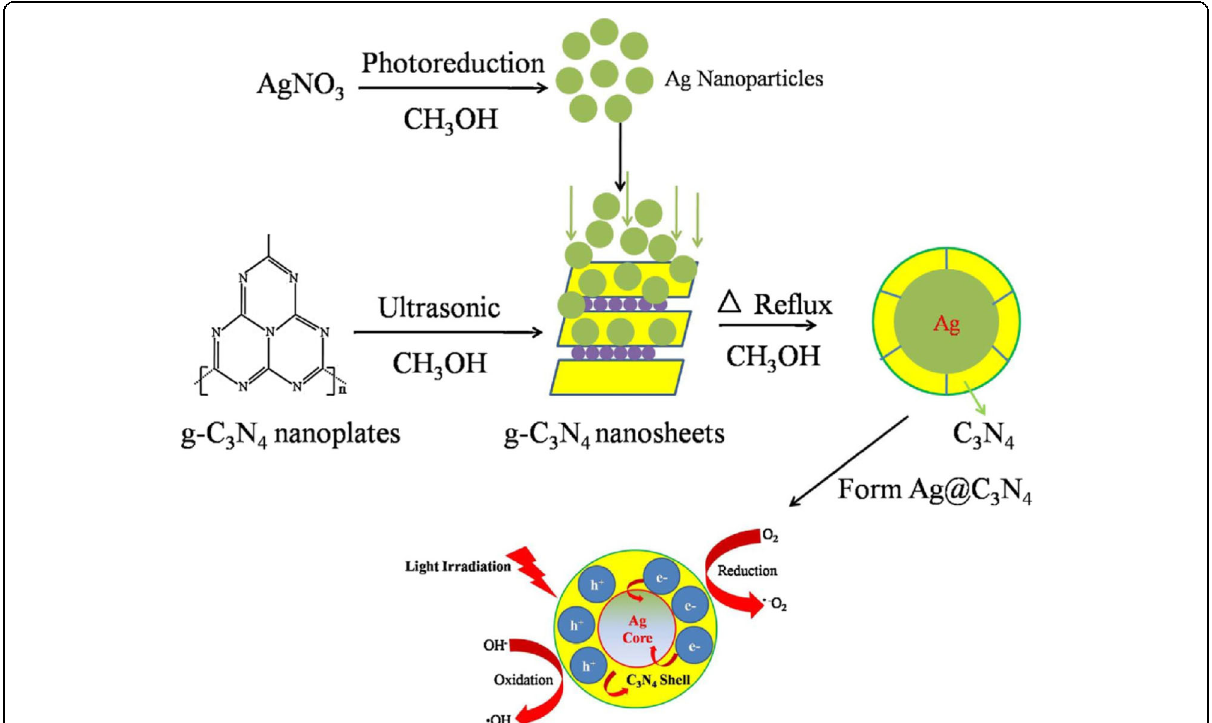
Fig. 10 Schematic drawing illustrating synthetic route (templating method) and the mechanism of charge separation and photocatalytic process over C3N4 and Ag@C3N4 photocatalysts under light irradiation. Reproduced with permission [124]. Copyright 2014